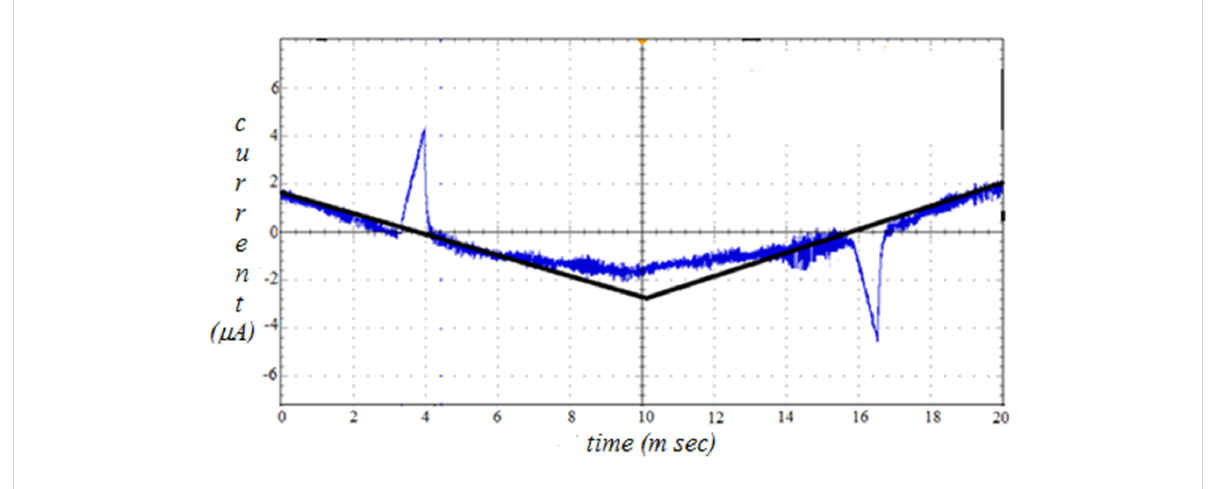
Figure 2: Polarization profile of 13br (C 12 .Ox.C*C 10 ) compound at 65 °C.